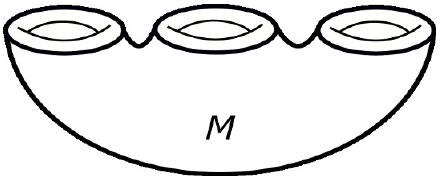
Figure 2 . A manifold M whose boundary (cid:6) has three components: (cid:6) = T 2 [ T 2 [ T 2 . Here the tori are unlinked, but it is straightforward to construct boundaries where they are non-trivially linked. One can de(cid:12)ne a quantum state on this kind of boundaries and study its entanglement